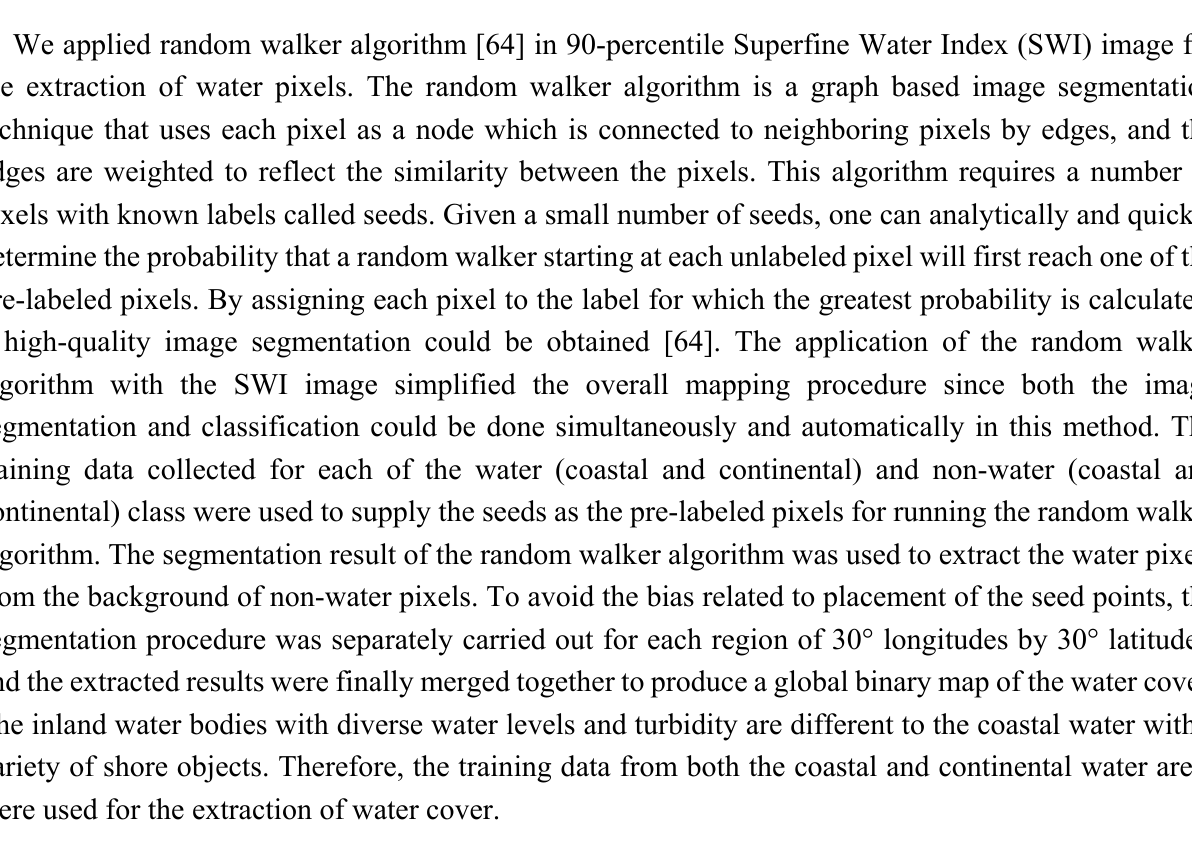
Figure 2. Distribution of the reference data belonging to the water and non-water areas used in the